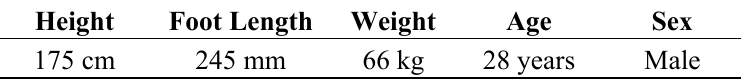
Table 3. Characteristics of the test